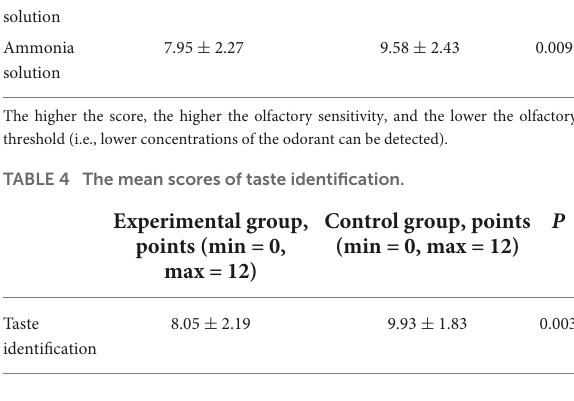
TABLE 5 Odor detection thresholds after recovery from COVID-19. Valerian root